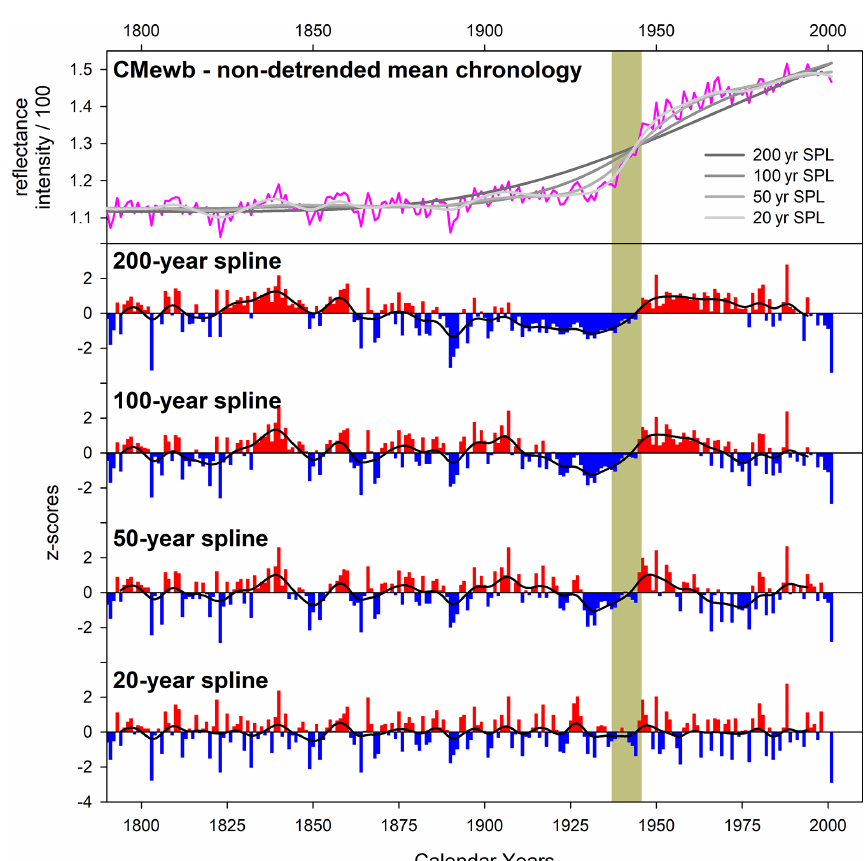
Figure A2. Upper panel: raw mean non-detrended EWB chronology for the CM pencil pine site. The lower panel shows progressively more flexible spline detrending options. The vertical grey bar denotes the heartwood–sapwood transition